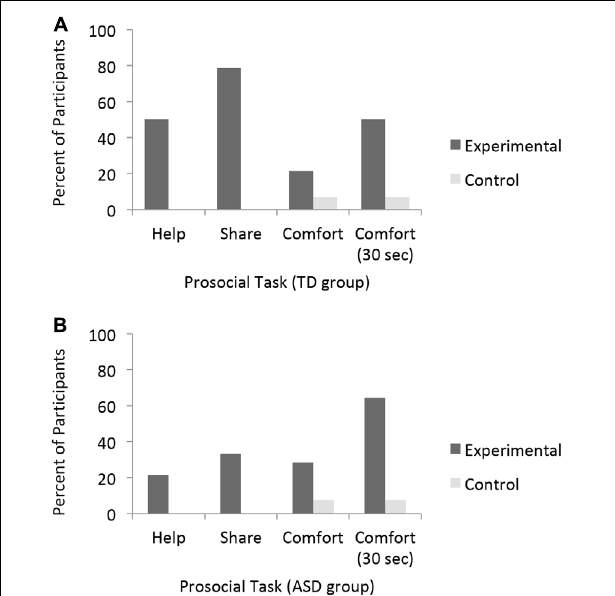
FIGURE 1 | Percent of Typically Developing participants (A) and participants with ASD (B) who responded to instrumental need, material desire, and emotional distress by condition. All Participants were given up to 10 s to respond except where noted (i.e., Comfort 30 s).